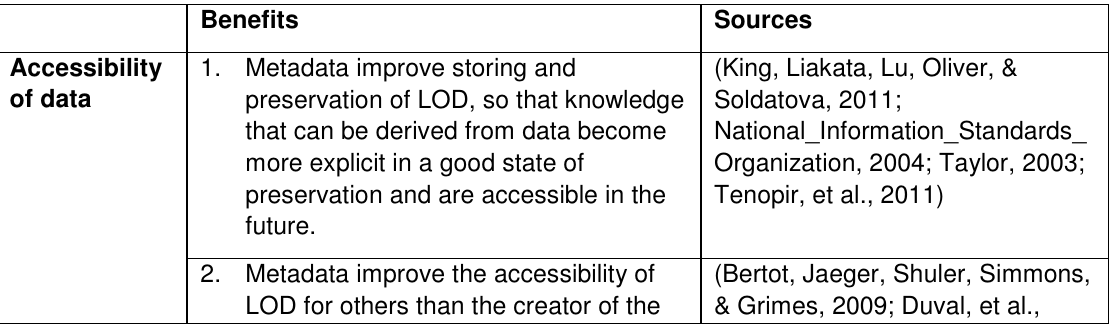
Table 2: Overview of advantages of metadata, derived from